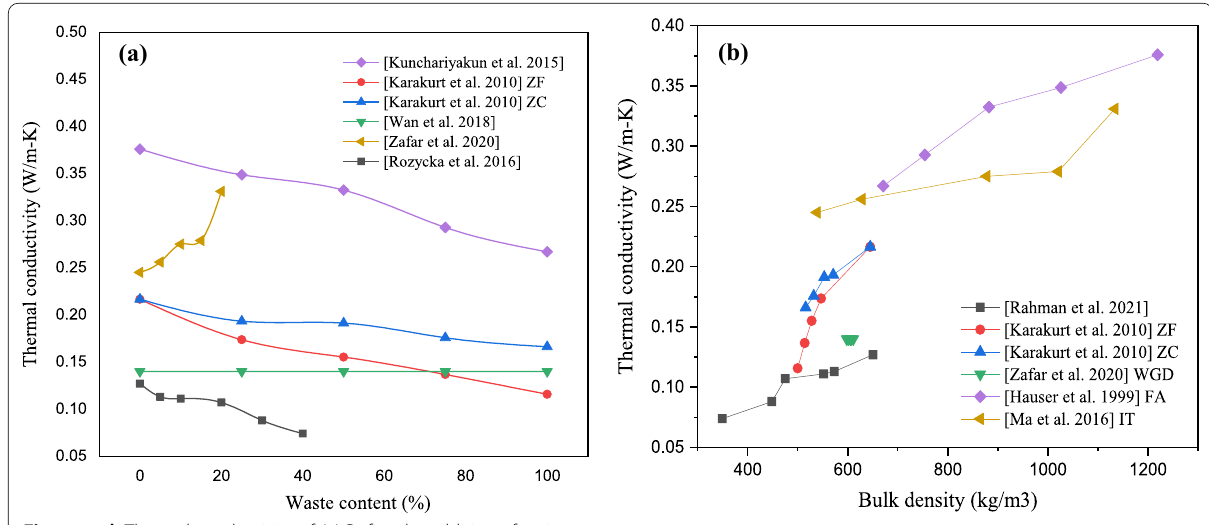
Fig. 14 a , b Thermal conductivity of AAC after the addition of various wastes